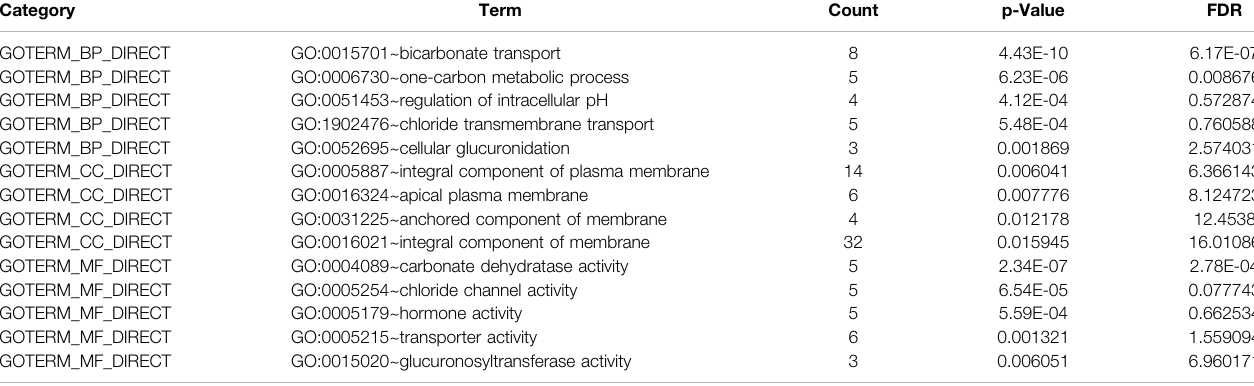
TABLE 3 | Gene ontology analysis results of down-regulated DEGs in CRC.